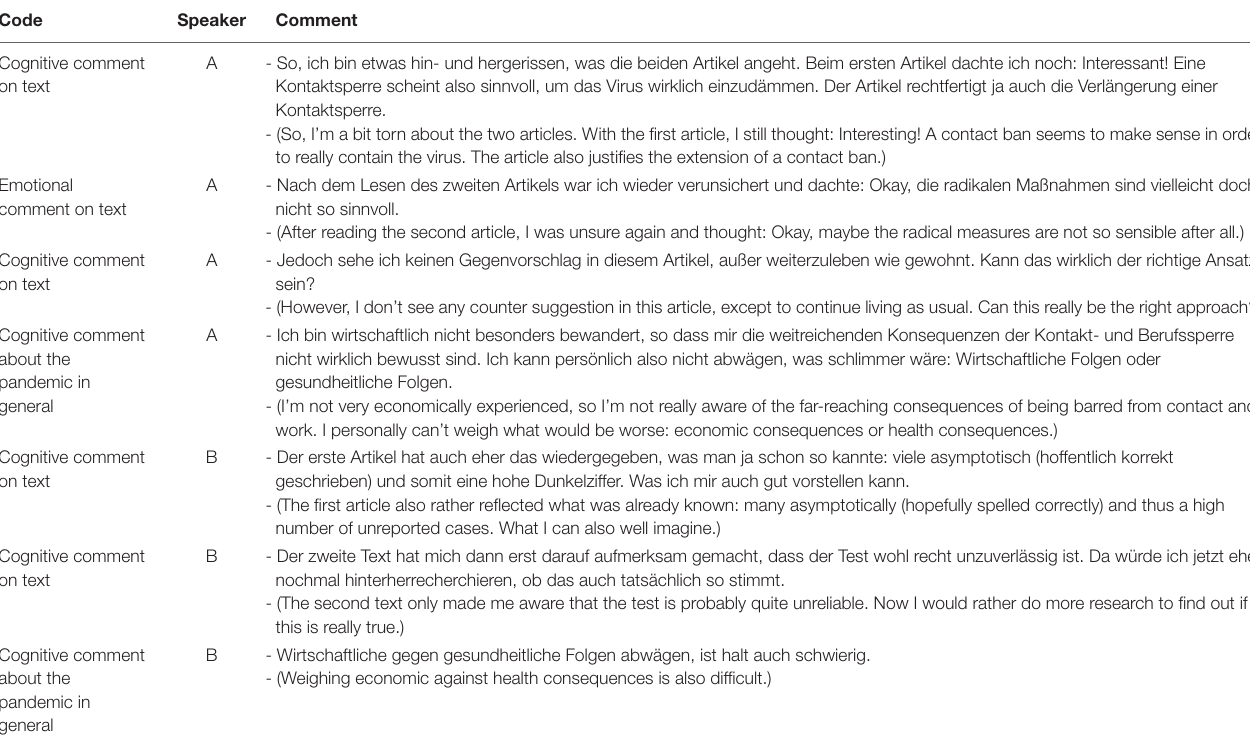
TABLE 2 | Example of a collaborative reasoning behavior (translation in